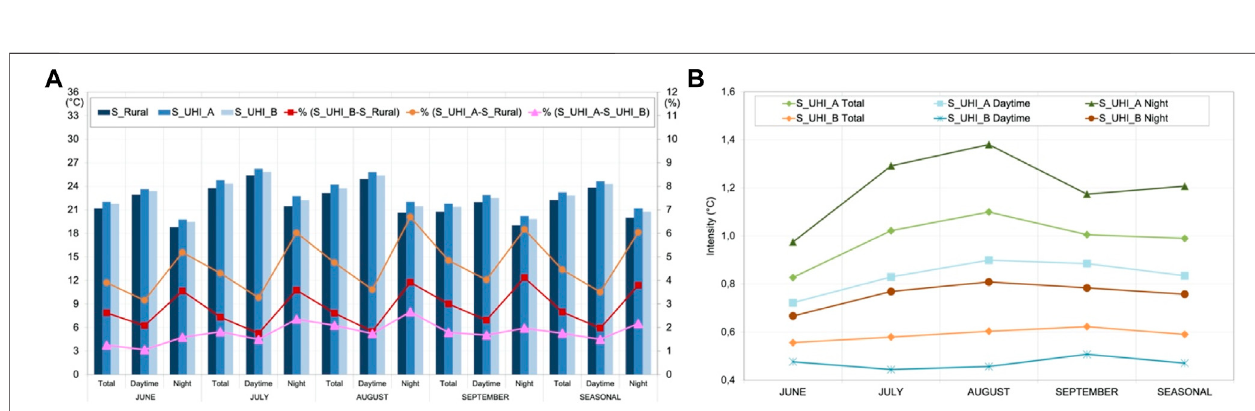
FIGURE 9 | Monthly and seasonal average air temperatures of rural and urban weather in case UHI_1 or UHI_2 in the three daily periods and their percent differences (A) in winter. The corresponding UHI intensities are shown in panel (B) .